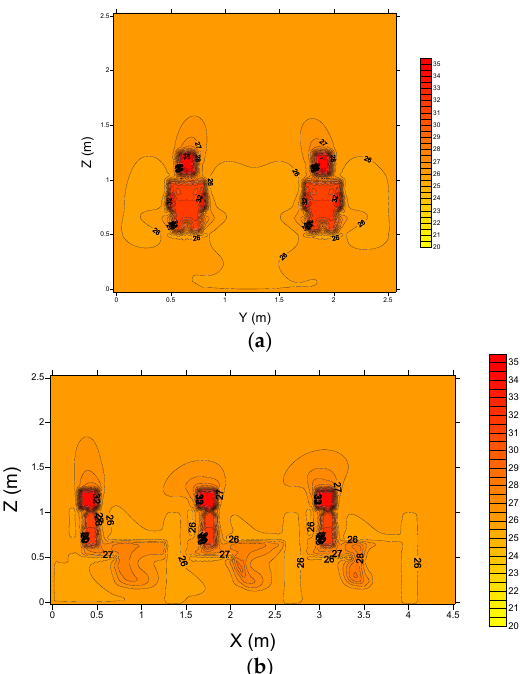
Figure 9. Air temperature field in the virtual classroom with 6 occupants in the plans ( a ) X = 1.791 m and ( b ) Y = 0.63099 m, with an inlet air temperature of 24 °C.